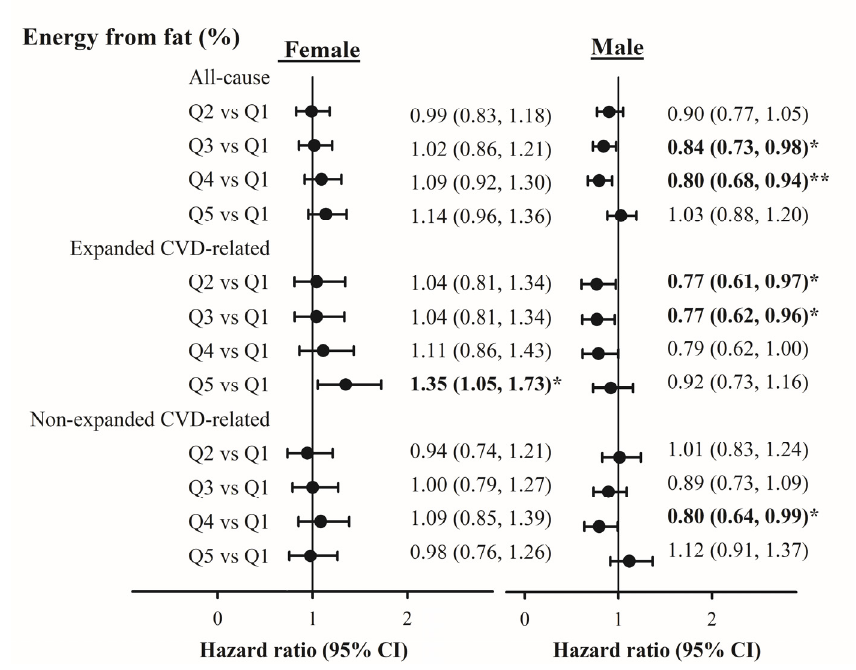
Figure 2. Associations between energy from fat and with risk of all-cause, expanded cardiovascular disease (CVD)-related, and non-expanded CVD-related mortality. Total Calcium Intake (Kcal):